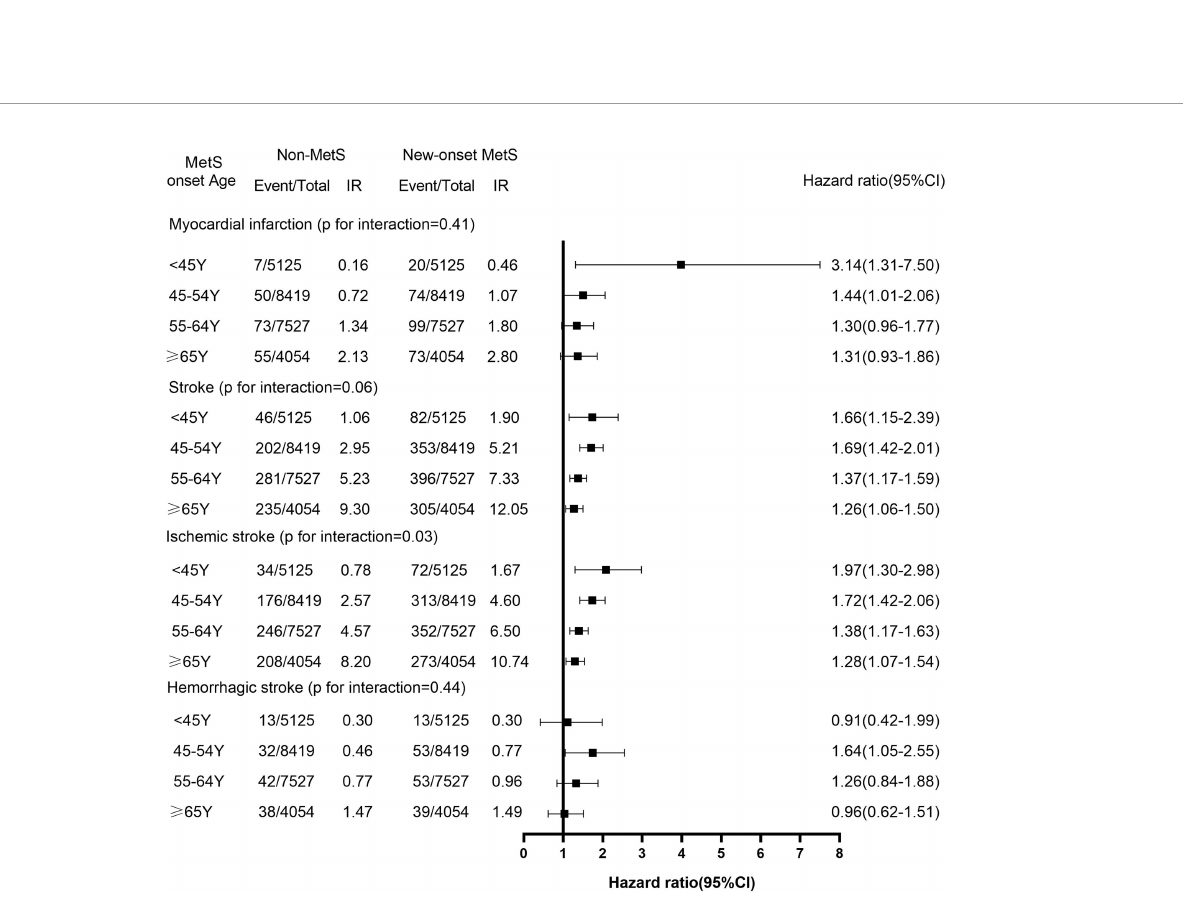
FIGURE 2 | The Hazard Ratios (95%CI) of the Subtypes of Cardiovascular Disease of New-Onset MetS Participants Across Age Group. IR, incidence rate (per 1000 person-years). The models were adjusted for HR, hs-CRP, ever-smokers, ever-drinkers, physical exercise, education and family history of cardiovascular disease. CI, con fi dence